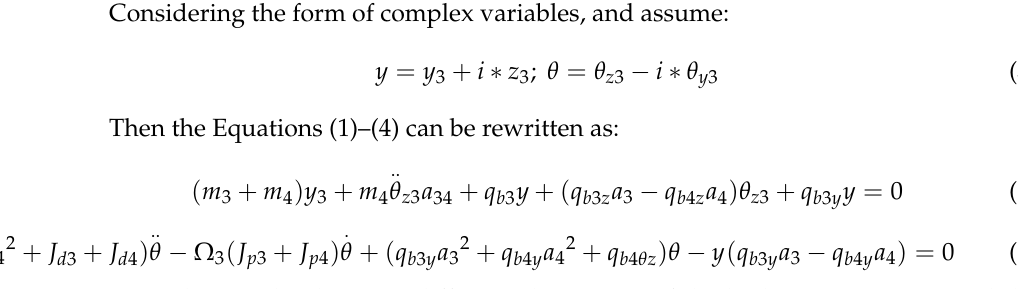
where q b 3 y , q b4y , q b 3 y , q b 4 y represent the stiffness of the 4# fulcrum and 6# fulcrum in the y rection in Figure 3.